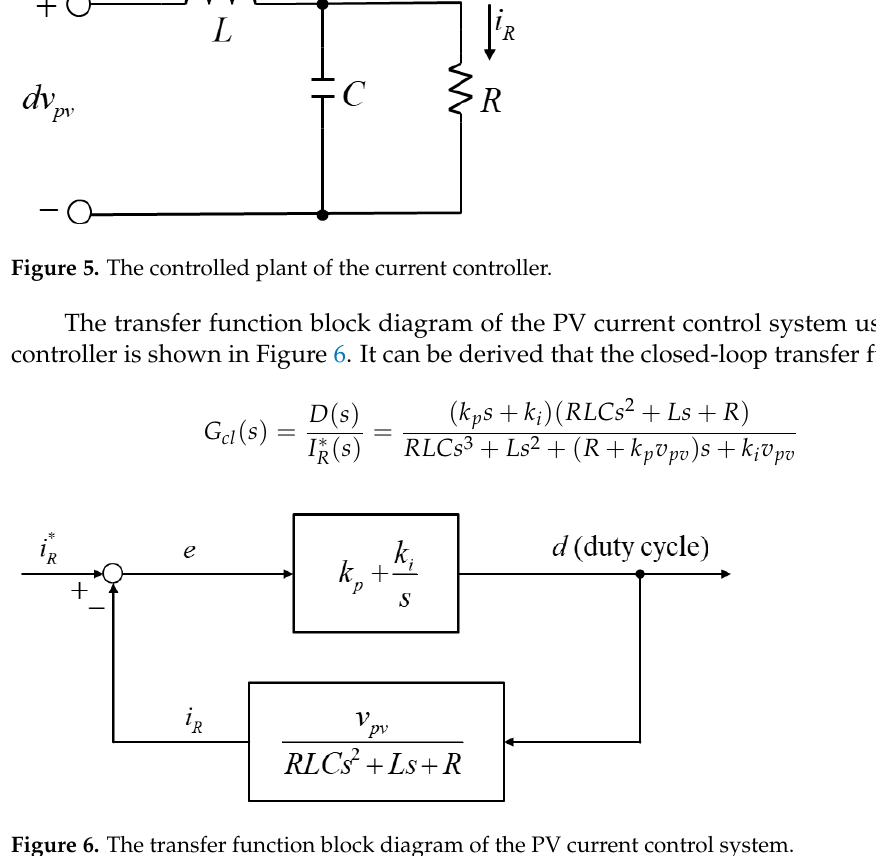
Figure 5. The controlled plant of the current controller.